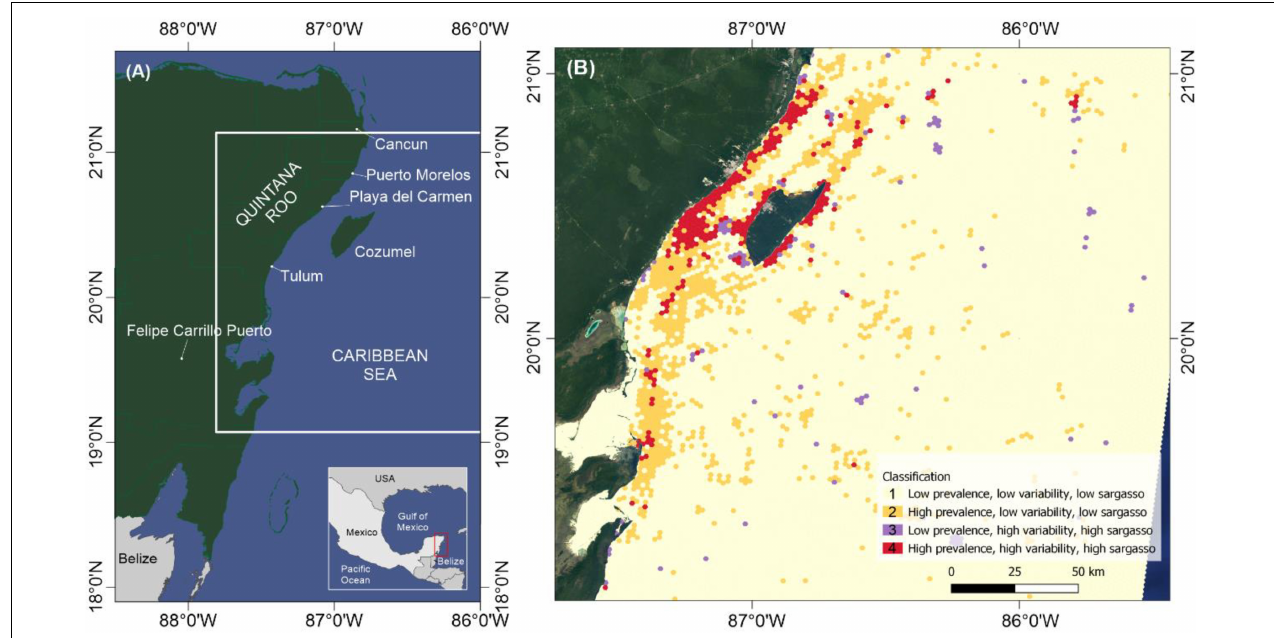
FIGURE 2 | (A) The Mexican Caribbean and (B) map showing the classification of sargasso, based on LandSat satellite data from 2016 to 2019.